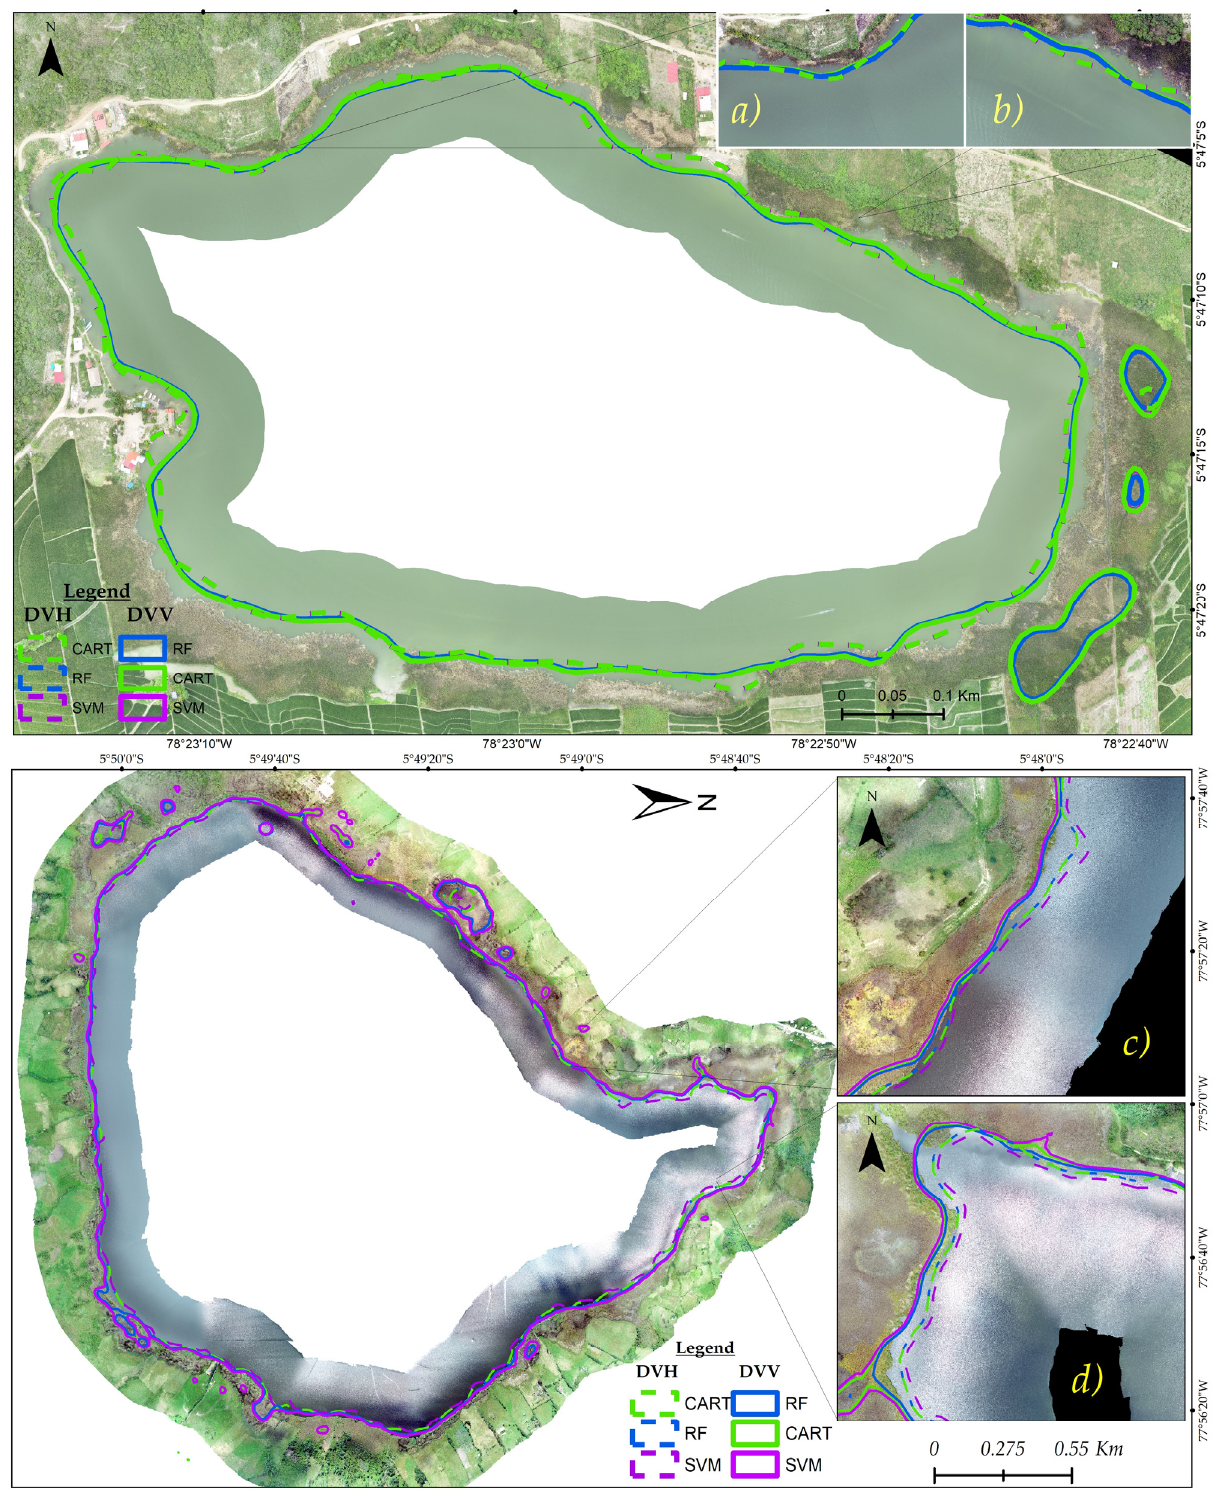
Figure 11. Overlapping of the SAR classification and orthomosaic of Burlan (top) and Pomacochas (bottom) Lakes for 2021-02-10, and subfigures ( a – d ) represent a zooming of each zone to visualize the classification result on the RPAS orthomosaic .